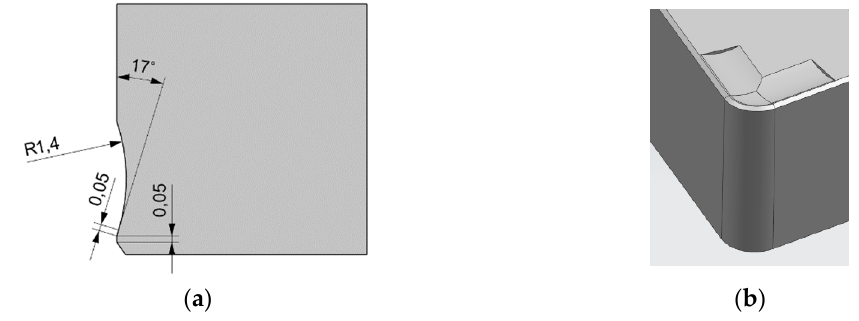
Figure 7. Chip breaker geometry result from the simulation study ( a ) cross-section in 2D ( b ) geometry in 3D [all dimensions as in mm].